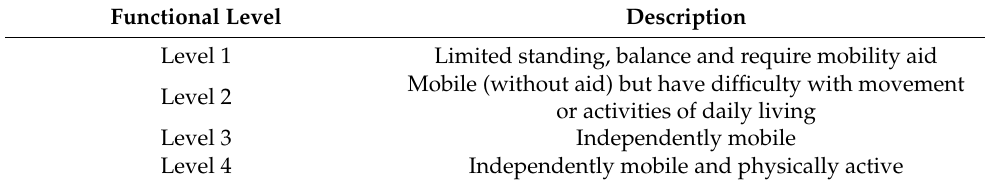
Table 1. Functionally stratified activity